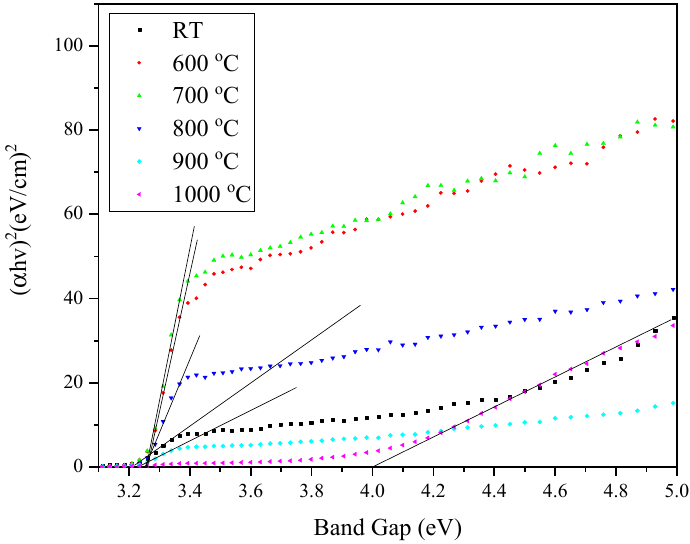
Figure 5. The optical band gap of the ZnO-SiO 2 composite at different sintering temperatures.